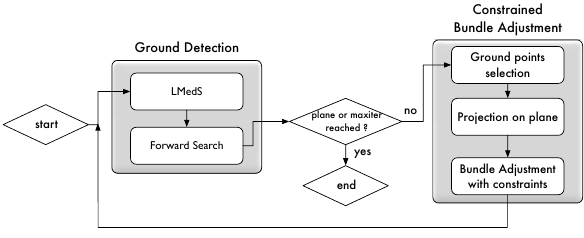
Figure 5. The flow chart of the proposed method which the coordinates are kept fixed and equal to their planar pro- jections Y i . Thus Equation (16) becomes